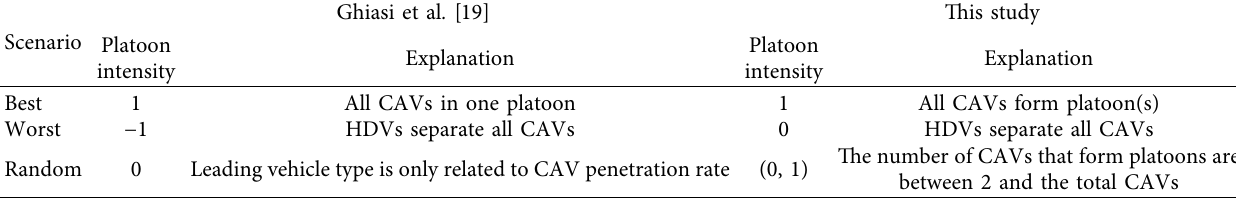
Table 1: Comparison of platoon intensity values ( p � 0 . 5).